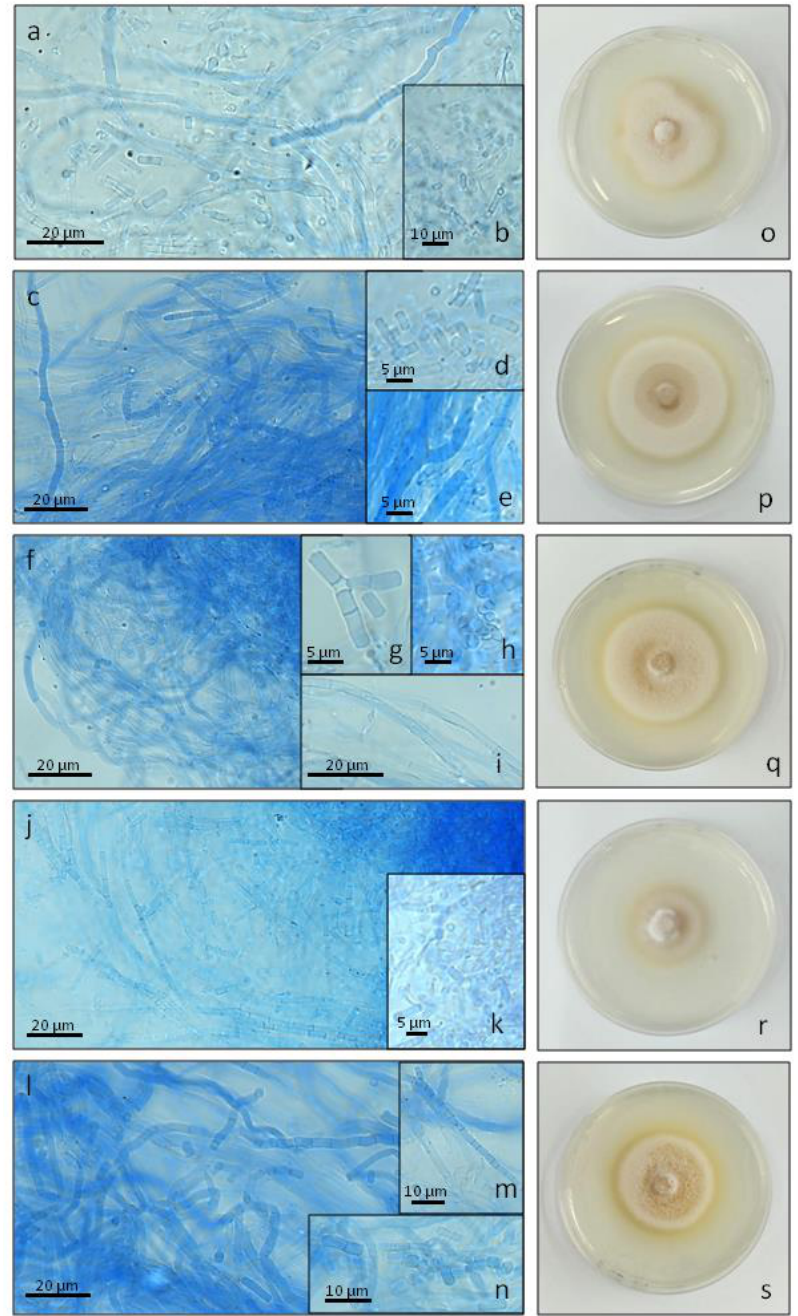
Figure 1. Confocal laser scanning micrographs of 5-day-old Cerrena unicolor cultures growing on 1.5% agar LH medium in white ( a , b ), dark ( c – e ), red ( f – i ), blue ( j , k ), and green ( l – n ) light conditions; Photographs of C. unicolor 5-day-old cultures growing on 1.5% agar LH medium in 90 mm Petri plates in white ( o ), dark ( p ), red ( q ), blue ( r ), and green ( s ) light